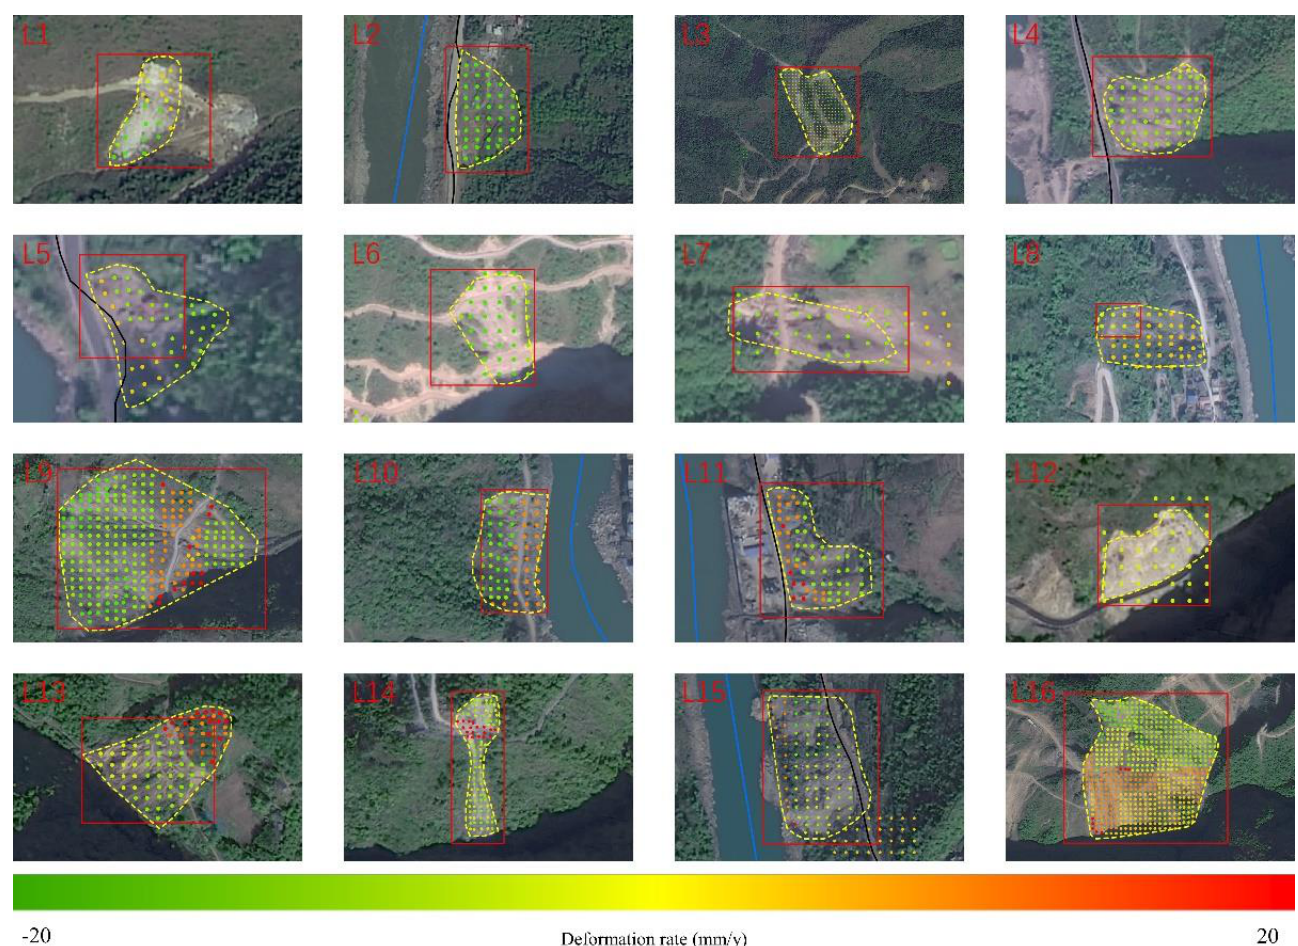
Figure 9. The examples of possible landslides identified by Yolo, which were also detected by SBAS − InSAR and verified by references. Here, the rectangles indicate Yolo results, scatter points represent SBAS results, and while yellow polygons indicate references.